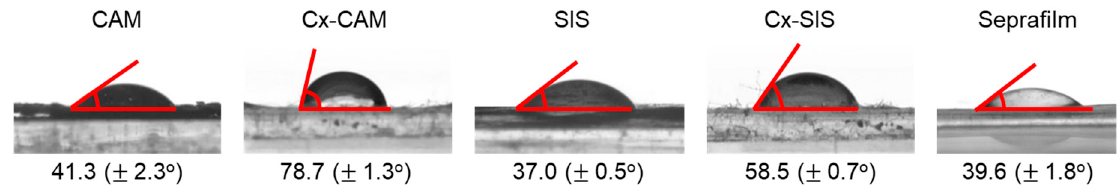
Figure 4. Images of a static droplet (side view) and contact angles of CAM, Cx-CAM, SIS, Cx-SIS films, and Seprafilm.